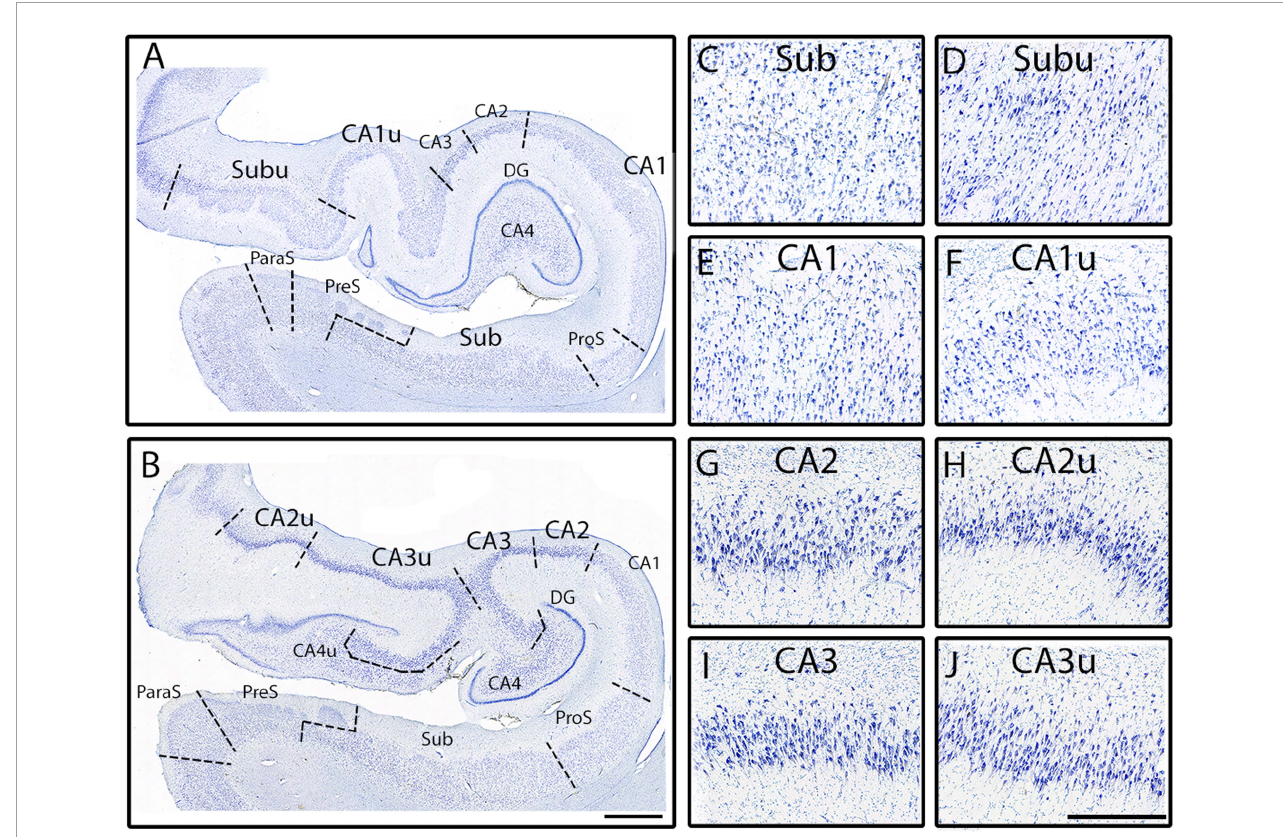
FIGURE6 The medial CA subfields versus the lateral CA subfields. Macro view of fully parcellated Nissl stained section at the full DG (A) and x-region (B) levels from Case 12. Panels (A,B) show the macro views of the meso views of Sub (C) , Subu (D) , CA1 (E) , CA1u (F) , CA2 (G) , CA2u (H) , CA3 (I) , and CA3u (J) . Note the clustering of neurons in the middle of the pyramidal layer in Subu, and the more homogenously distributed pyramidal layer of Sub. CA1 and CA1u contain smaller and more lightly stained neurons, as well as less densely packed, than those in CA2, CA2u, CA3, and CA3u. Both CA2 and CA2u contain neurons that exhibit less collinearity than the neurons observed in CA3 and in CA3u. Finally, note how all medial subfields (denoted with a “u” at the end of the subfield name; far right panels) have smaller neurons than their lateral counterpart. Magnification bar for panels (A,B) : 2 mm, for panels (C–J) : 500 µ